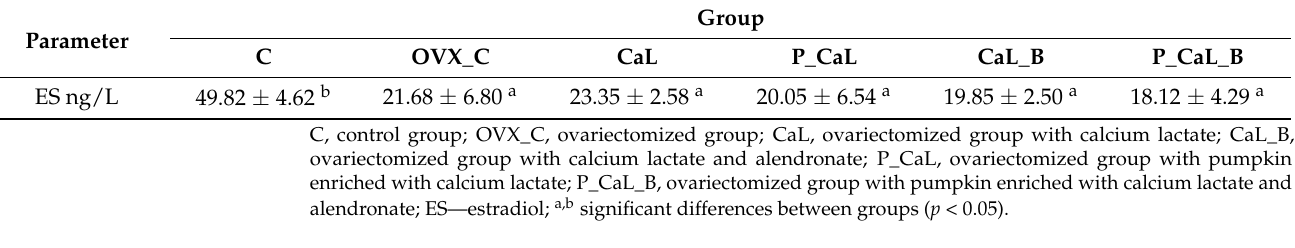
Table 3. The level of estradiol in serum of rats (mean and standard